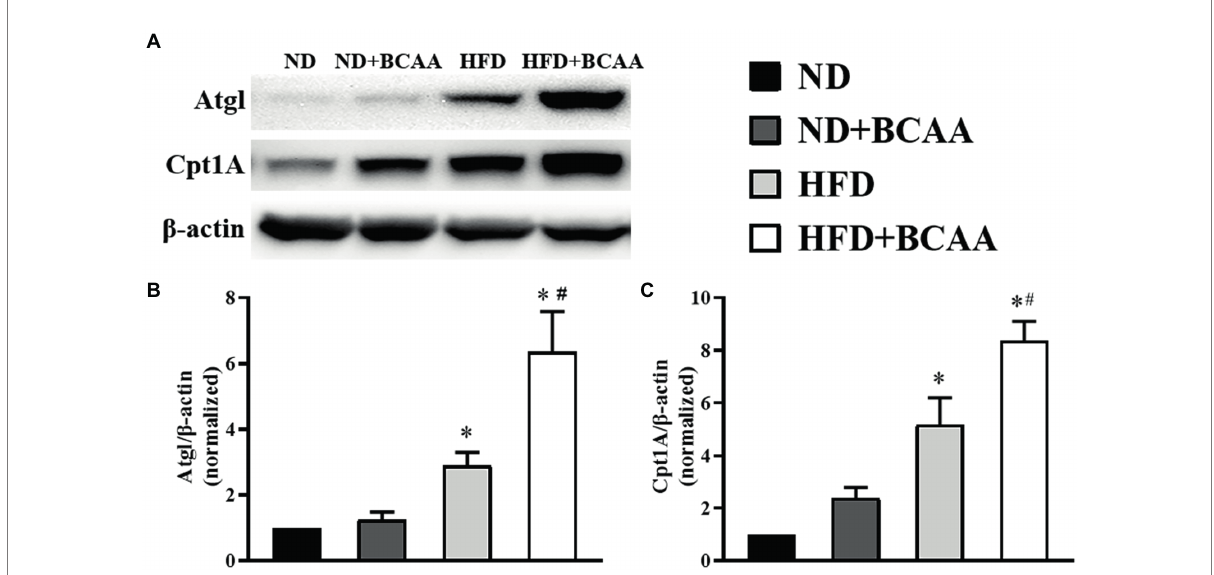
FIGURE 5 Effect of BCAAs on the lipid hydrolysis and oxidation-related protein expression in HFD-fed mice. The protein expression of (A) adipocyte triglyceride lipase (Atgl) and carnitine palmitoyl transferase 1A (Cpt1A) in the liver. The relative quantitative data for (B) Atgl and (C) Cpt1A as indicated. The densitometries were normalized to β -actin ( n = 6). The data are presented as the mean ± SEM. * p < 0.05 vs. the ND group; # p < 0.05 vs. the HFD